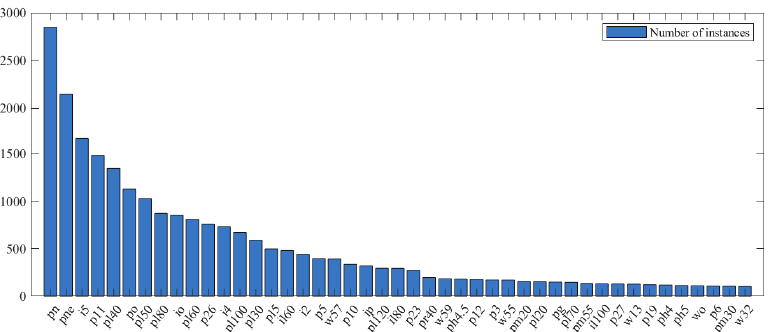
Figure 7. Distribution of instances for the TT100K dataset.